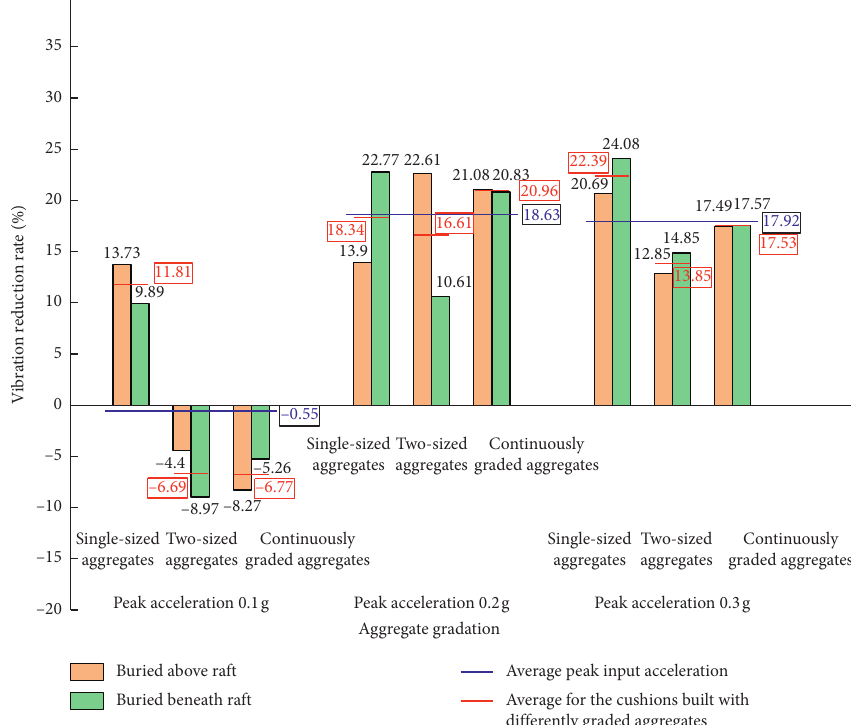
Figure 10: Vibration reduction rates of cushion at different parameter